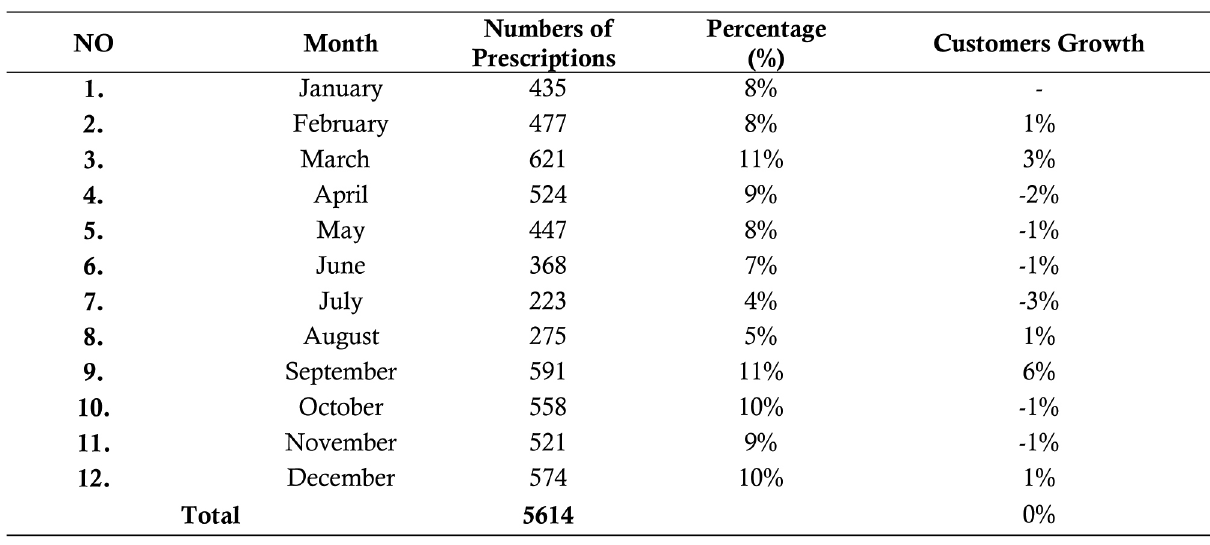
Measurement Result of Customers Growth in UMC Pharmacy year